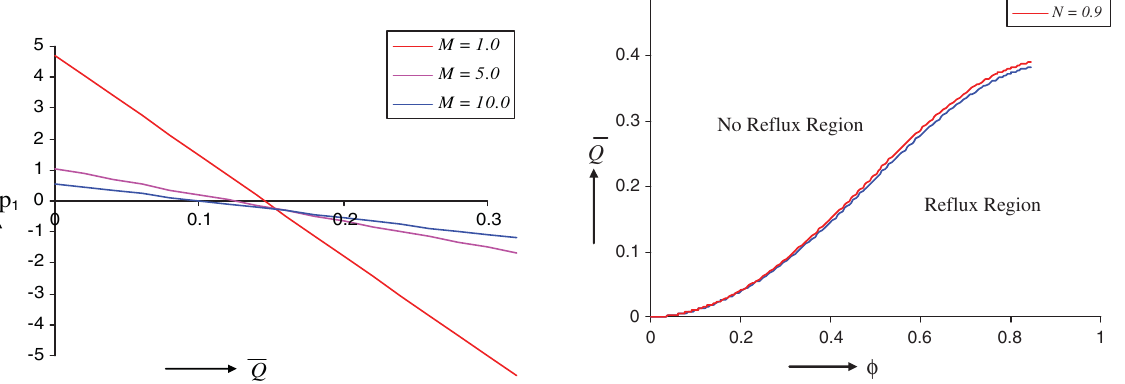
Fig. 9. Pressure difference across one wavelength vs. average flow rate based on Eq. (34) for M =1.0–5.0, φ =0.4 and N =0.50.